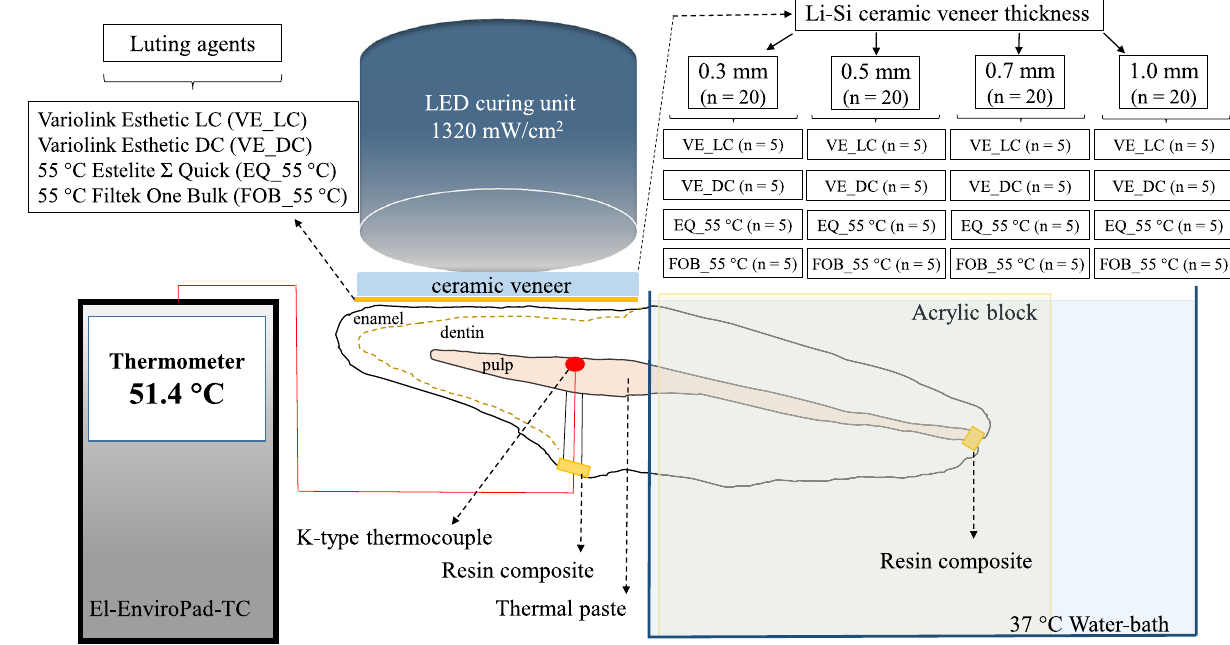
Figure 1. Schematic figure of the experimental set-up for pulpal temperature